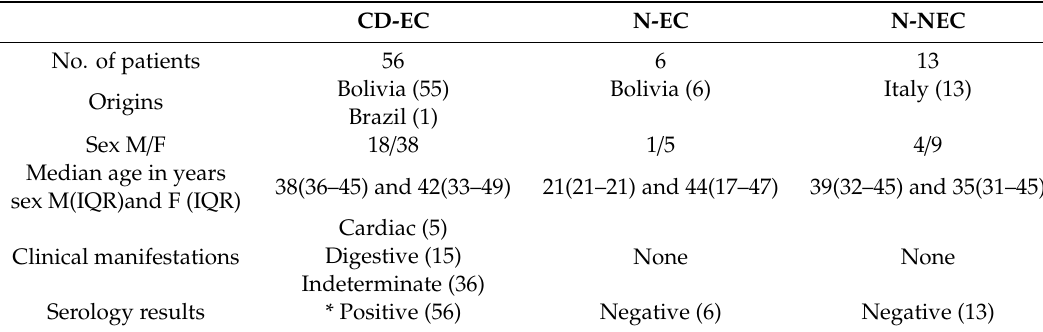
Table 1. Subjects demographic